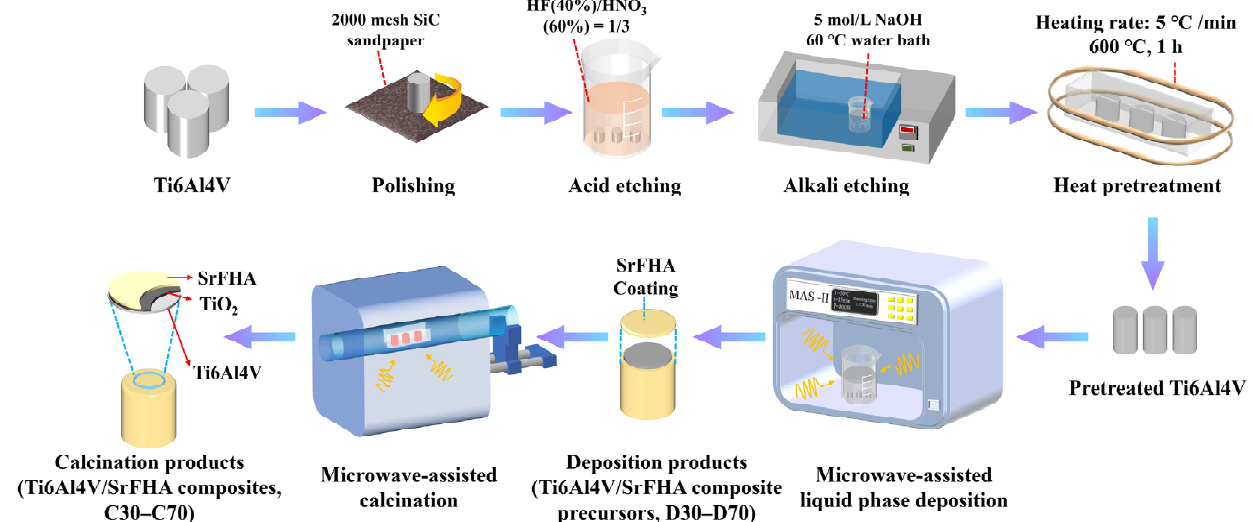
Figure 1. Schematic illustration of the synthesis process of Ti6Al4V/SrFHA composites.